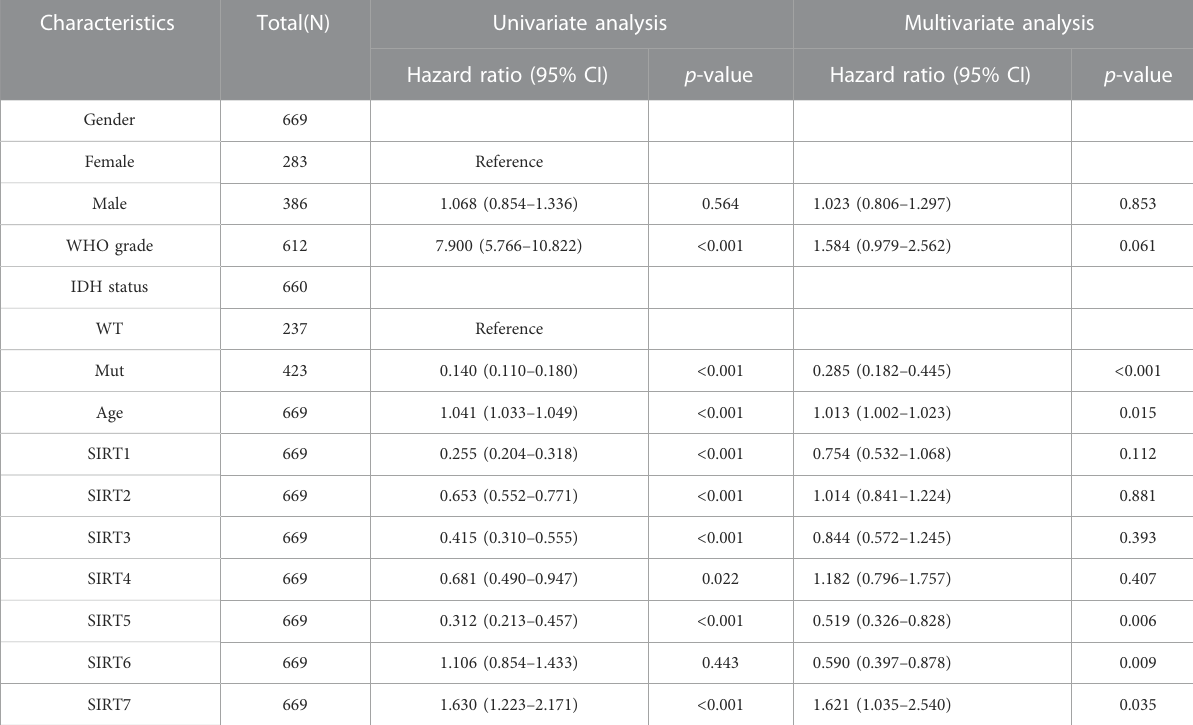
TABLE 3 SIRT family and clinical characteristics as analyzed by PFI-based univariate and multivariate Cox regression in the TCGA database.